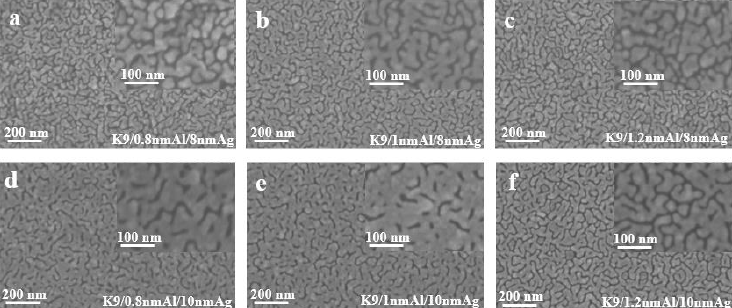
Figure 5. SEM images of silver films with aluminum seed layer of different thickness ( a – f ).